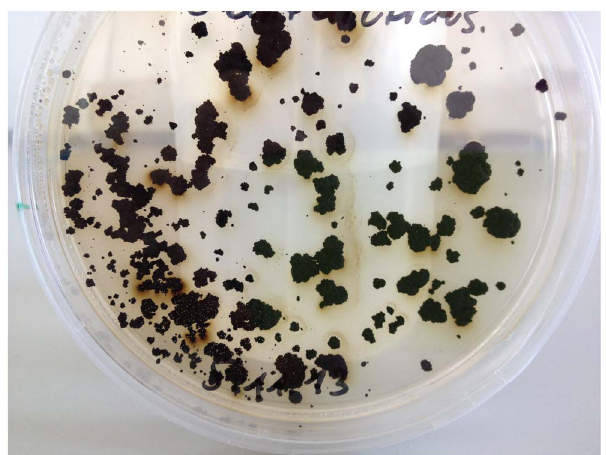
Figure 1. Growth of Cryomycesantarcticus on agar plate.